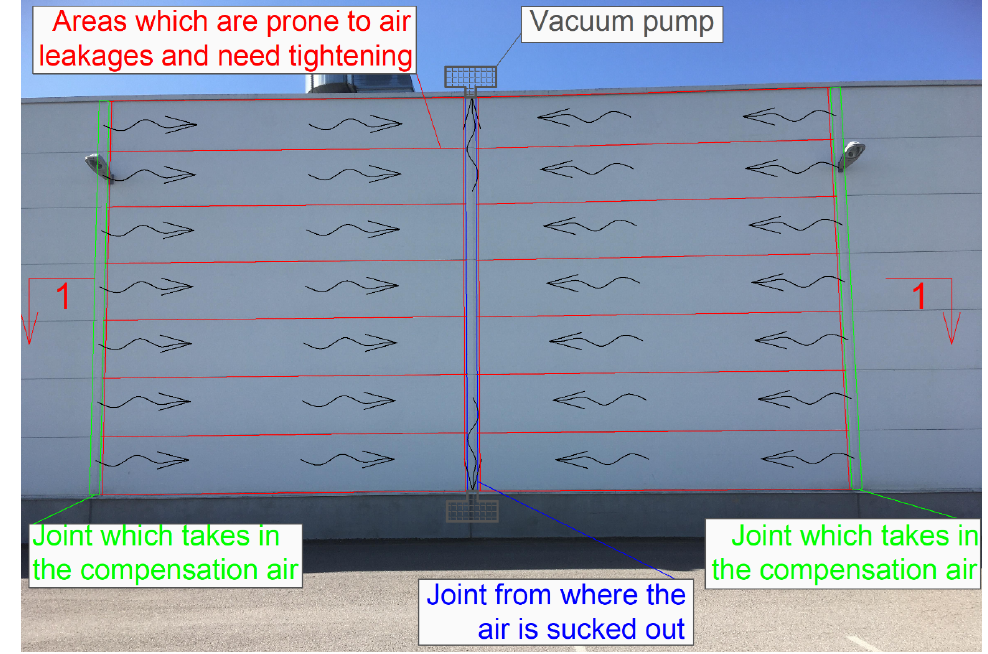
Figure 9. Scheme on facade for ventilated vertical joints and compensation air